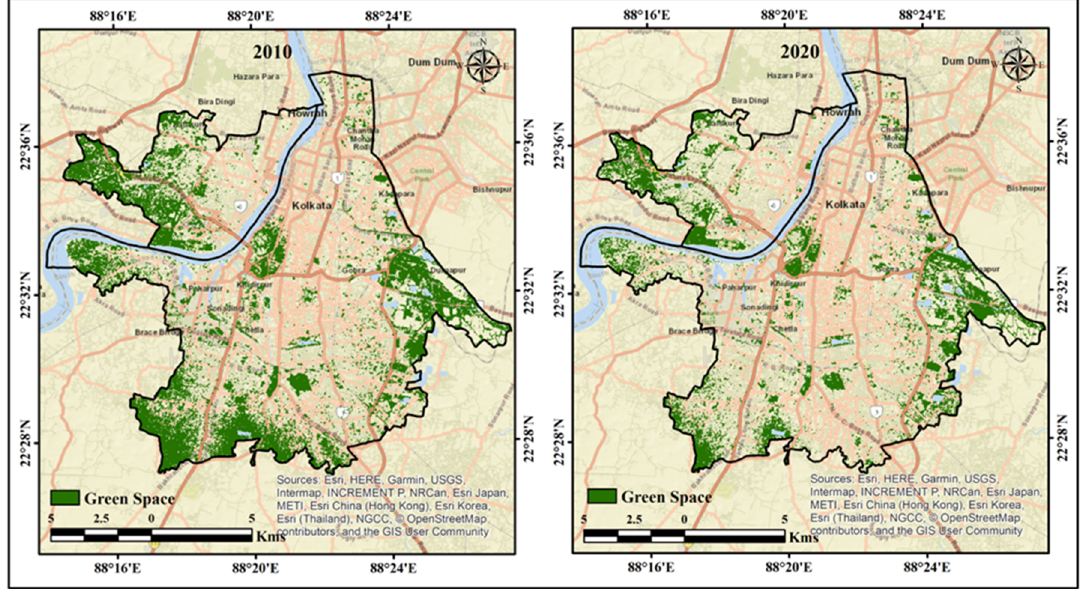
Figure 11. Green space dynamics in 2010 and 2020 for West Bengal (Kolkata and Howrah).